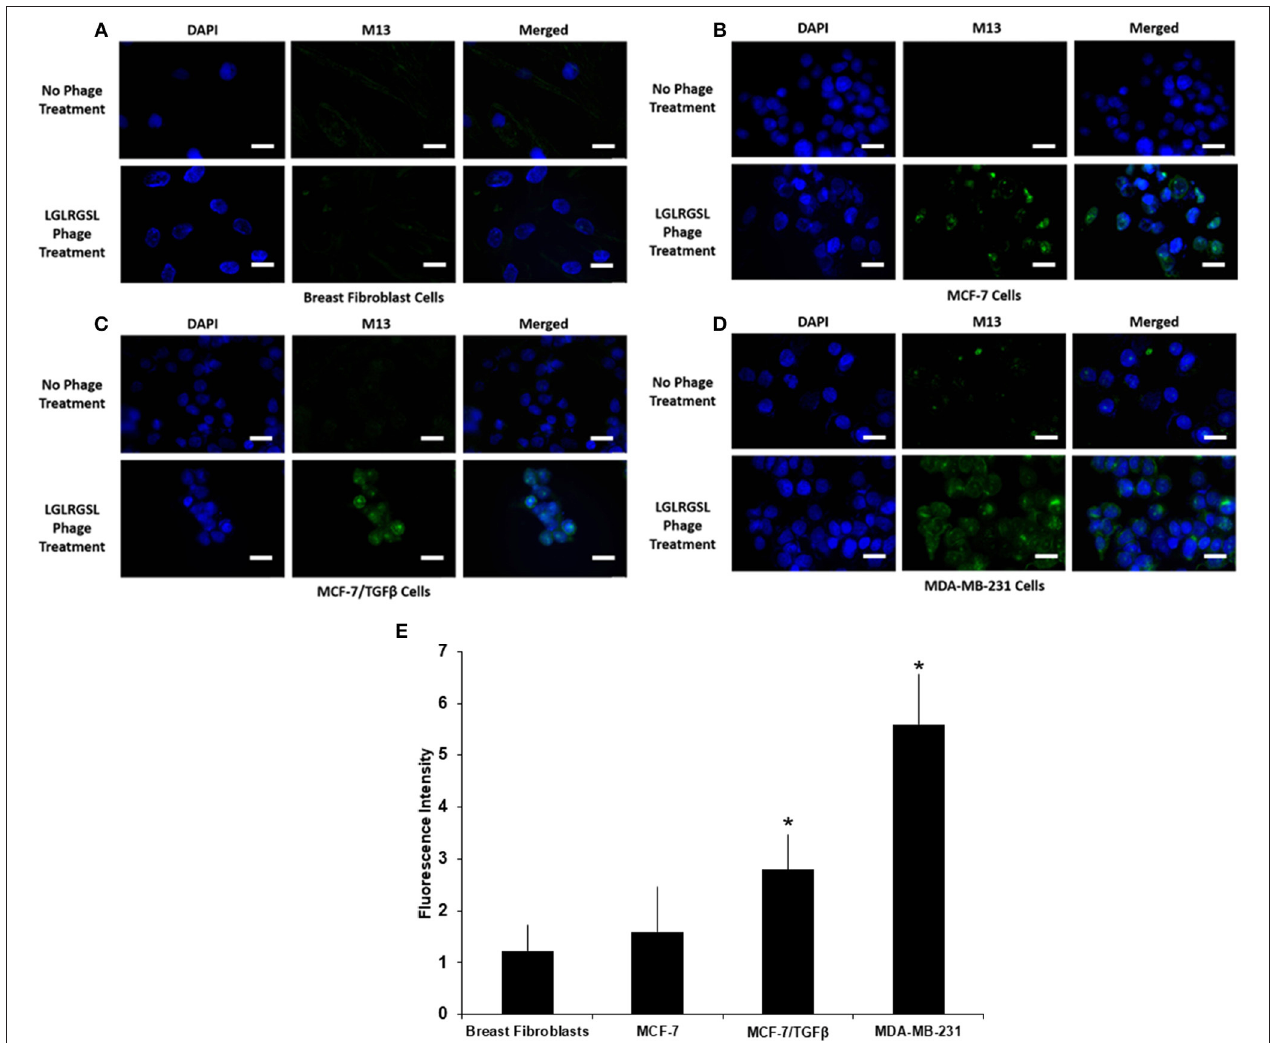
FIGURE 4 | A. Phage peptide LGLRGSL (E11) stained selective to EMT phenotypic cells in immunofluorescence microscopy analysis upper, (A) Breast Fibroblast, (B) MCF-7, (C) MCF-7/TGF β , and (D) MDA-MB-231 cells without phage exposure; stained with DAPI and Alexa 488 secondary antibody, lower, (A) Breast Fibroblasts, (B) MCF-7, (C) MCF-7/TGF β , and (D) . MDA-MB-231 exposed to phage; stained with M13 primary antibody, DAPI and Alexa 488 secondary antibody. Scale bar is 20 µ m. (E) Quantification data of the fluorescence intensity of the Breast fibroblasts, MCF-7, MCF-7/TGF β , and MDA-MB-231 breast cancer cells. The fluorescence intensity of the images was quantified using Image J software. All data represent the mean ± S.D of three different experiments. * p < 0.05, student- t